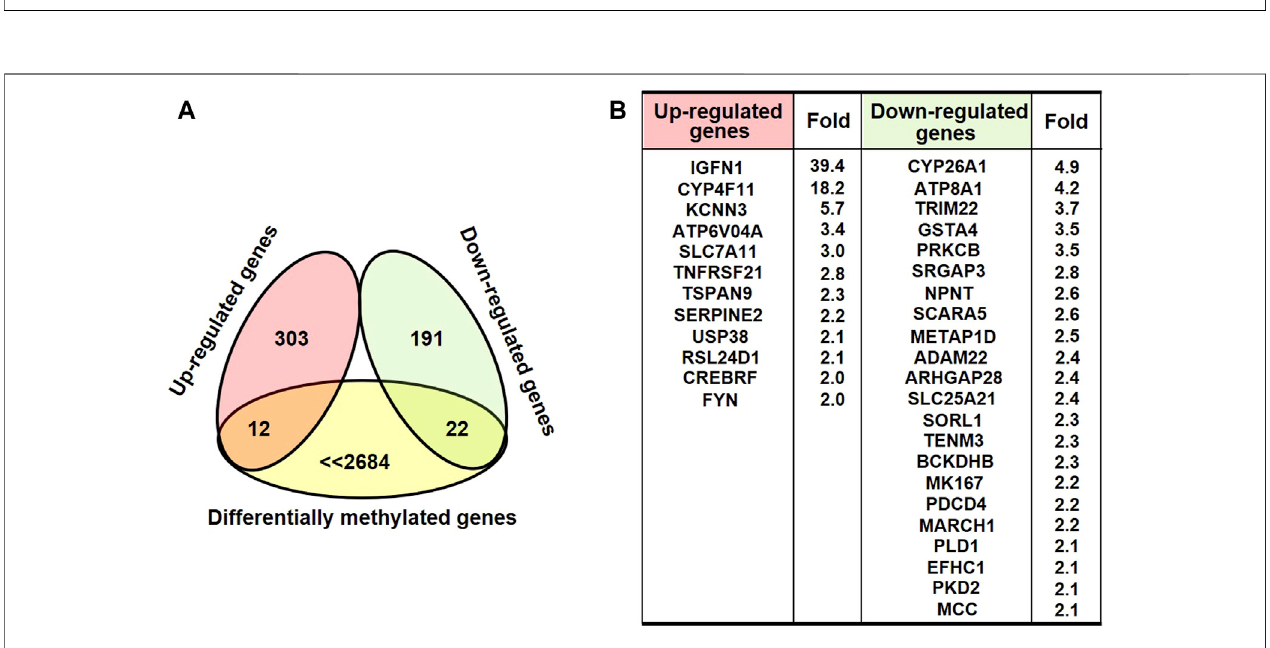
FIGURE 5 | The analysis of differential expressed and methylated genes in HEK293T cells treated with AgNPs. (A) The Venn diagram illustrating the differential expressed genes with relevant methylation change in HEK293T cells upon AgNPs. (B) The list and the fold for the differential expressed and methylated genes.